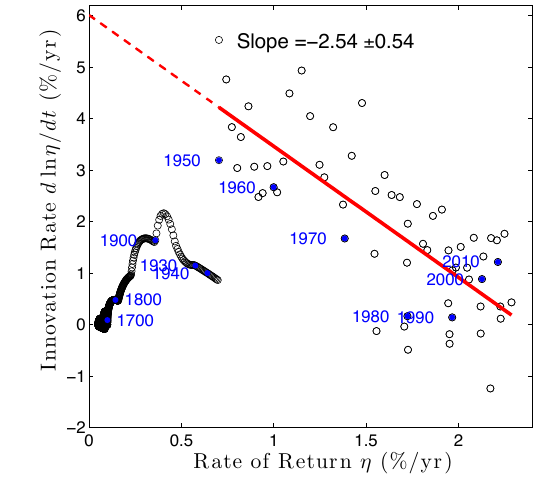
Figure 6. The global innovation rate dln η/ d t versus the global t R Y d t (cid:48) (Eq. 4). Select years are shown for rate of return η = Y/ 0 reference. Since 1950, innovation is related to growth through the functional relationship dln η/ d t = Sη + b , where the slope and in- tercept shown by the red line, with 95% confidence limits, are S =− 2.54 ± 0.54 and b = 0.06 ±